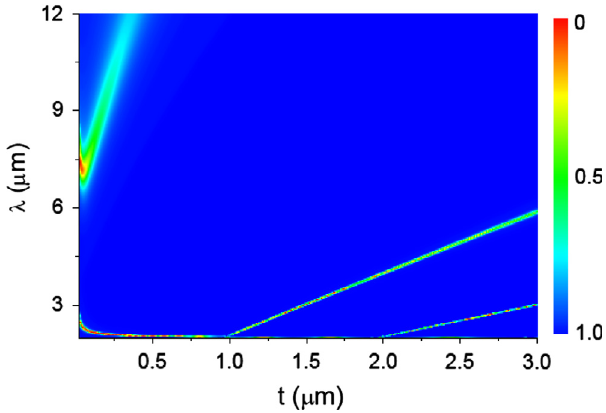
Figure 12. Reflection spectrum as a function of wavelength and spacer thickness, where a transition from the SFP resonance (in the slits) to the common FP resonance (in the spacer) is present. Here, d = 2000 nm, a = 50 nm, and h = 100